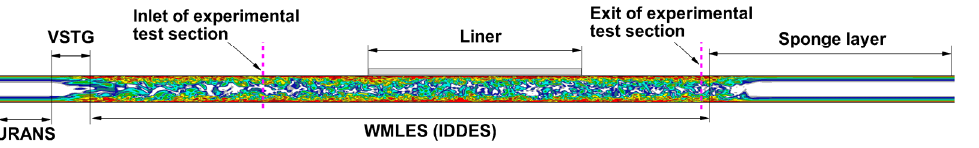
Figure 5. Schematic of XY -cut of the computational domain used in zonal RANS-IDDES showing locations of the VSTG and the exit sponge layer together with an example of an instantaneous field of vorticity magnitude.